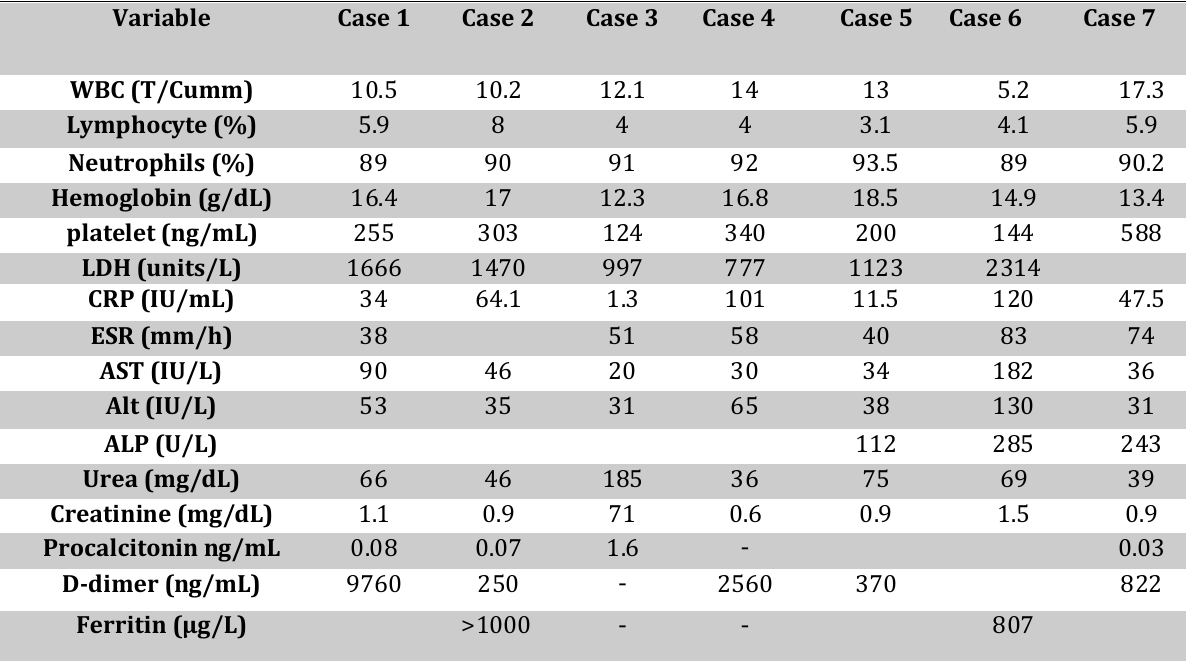
Table 1. Laboratory data related to the presented